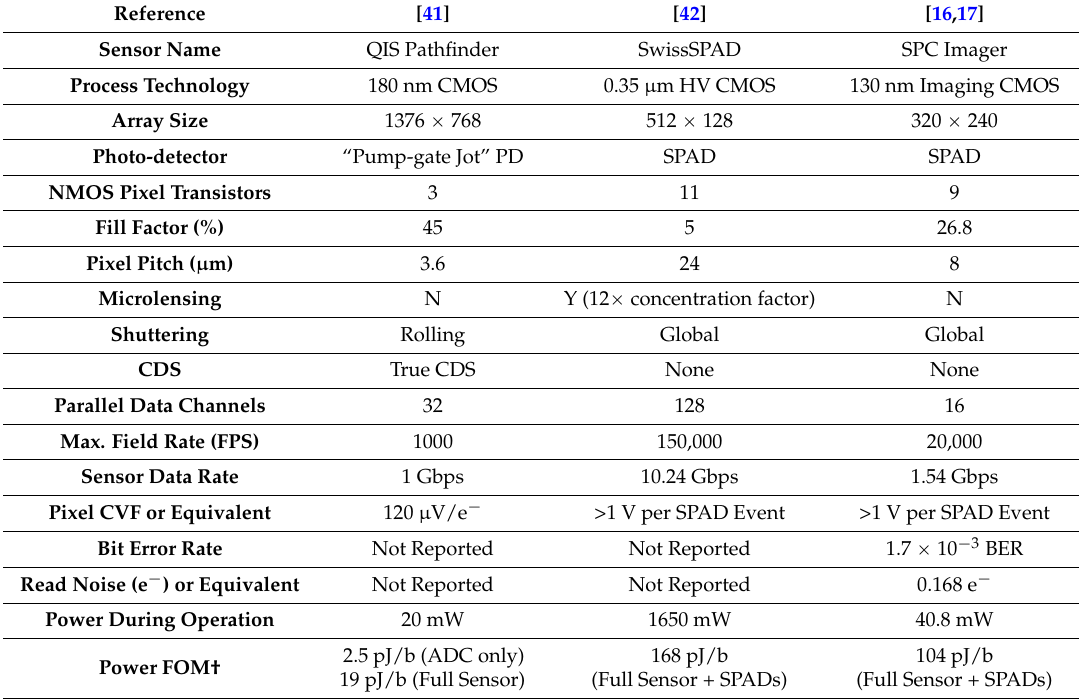
Table 3. Binary capture, oversampled output, quanta image sensor comparison table. FOM† = Sensor power/(No. of Pixel ˆ FPS ˆ N), where N = ADC resolution = 1b for these